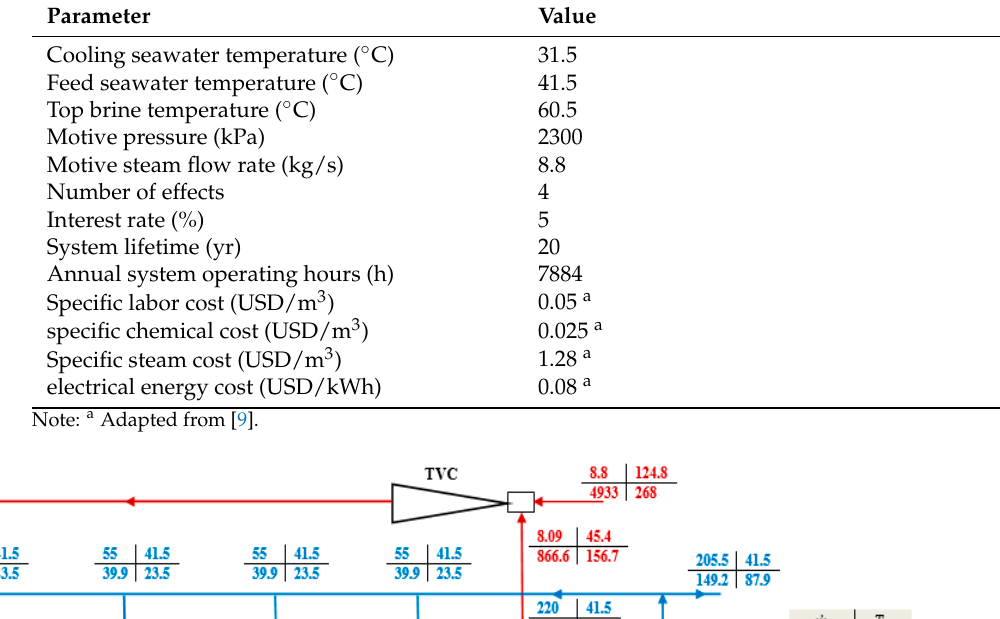
Table 3. Parameters assumed for the simulations.